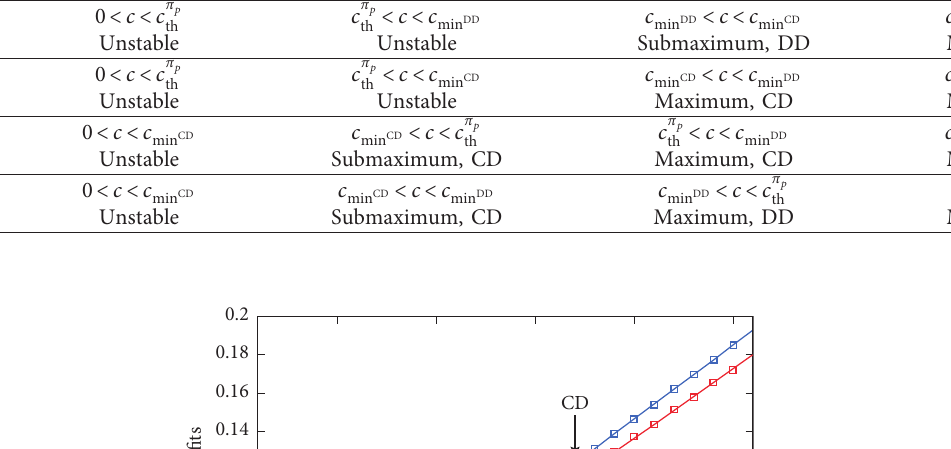
Table 5: The final decisions and the corresponding parameter value range in four scenarios.